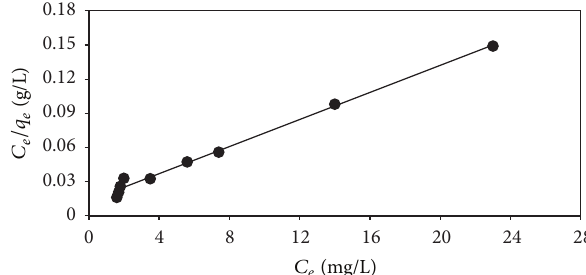
Figure 11: Langmuir adsorption isotherm of RR-RB onto QKCF (temp. = 25 ∘ C, agitation speed = 200 rpm, time = 24 hr., and initial dye concentration = 100mg/L).